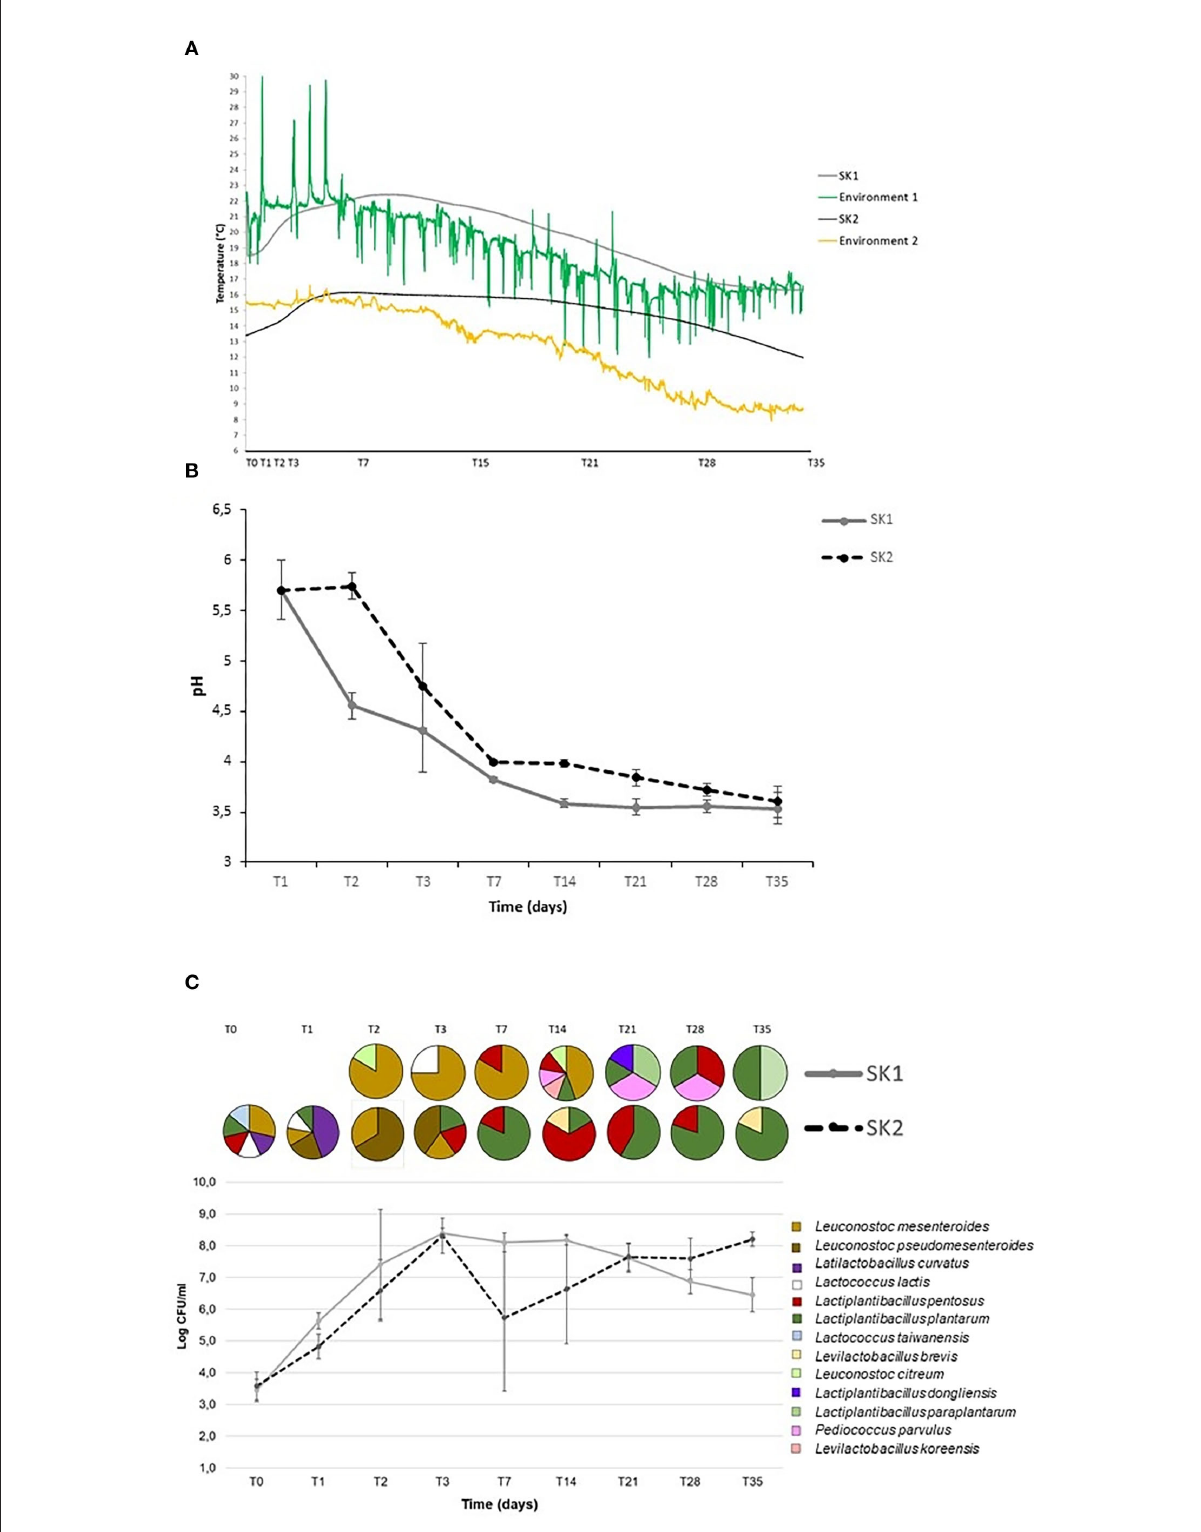
FIGURE1 Temperature ( ◦ C) (A) , pH (B) , and bacterial counts (CFU/mL) (C) during sauerkraut fermentations (mean and standard deviation n = 5 tanks for SK1 and SK2). The circles represent the percentage of bacterial strains isolated and identified at each time